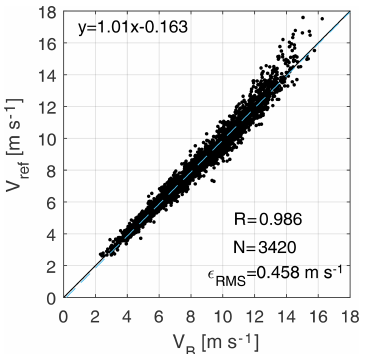
Figure 6. Corrected bending-load-based rotor-effective wind speed V B (Eq. 3) vs. met-mast reference wind speed V ref (Eq.